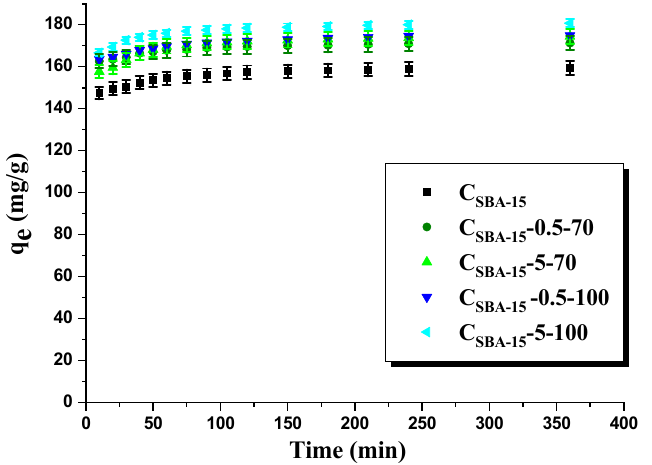
Figure 3. Amount of rhodamine B adsorbed on adsorbents obtained (C 0 − 75 mg/L). Table 3. Kinetic models parameters.